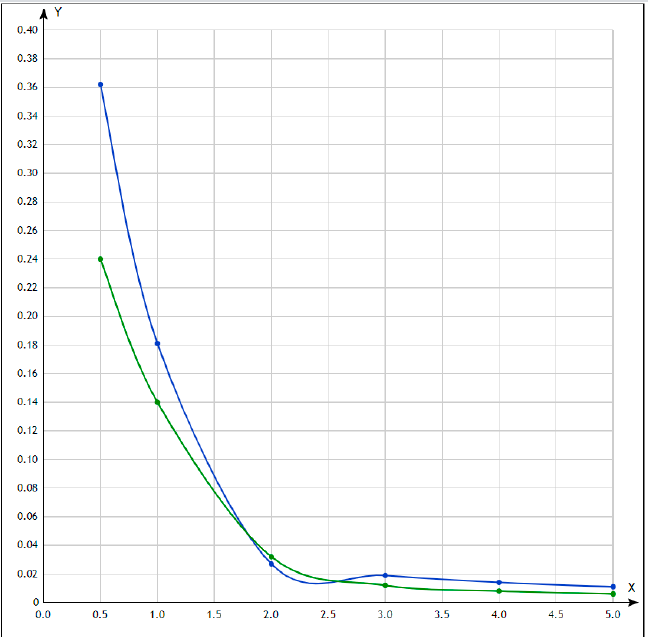
Figure 13. Analysis of the dependence of the area of infection on the wind speed at the corresponding depths of hazardous chemicals according to the existing method (blue) and by the method of random addition (green).